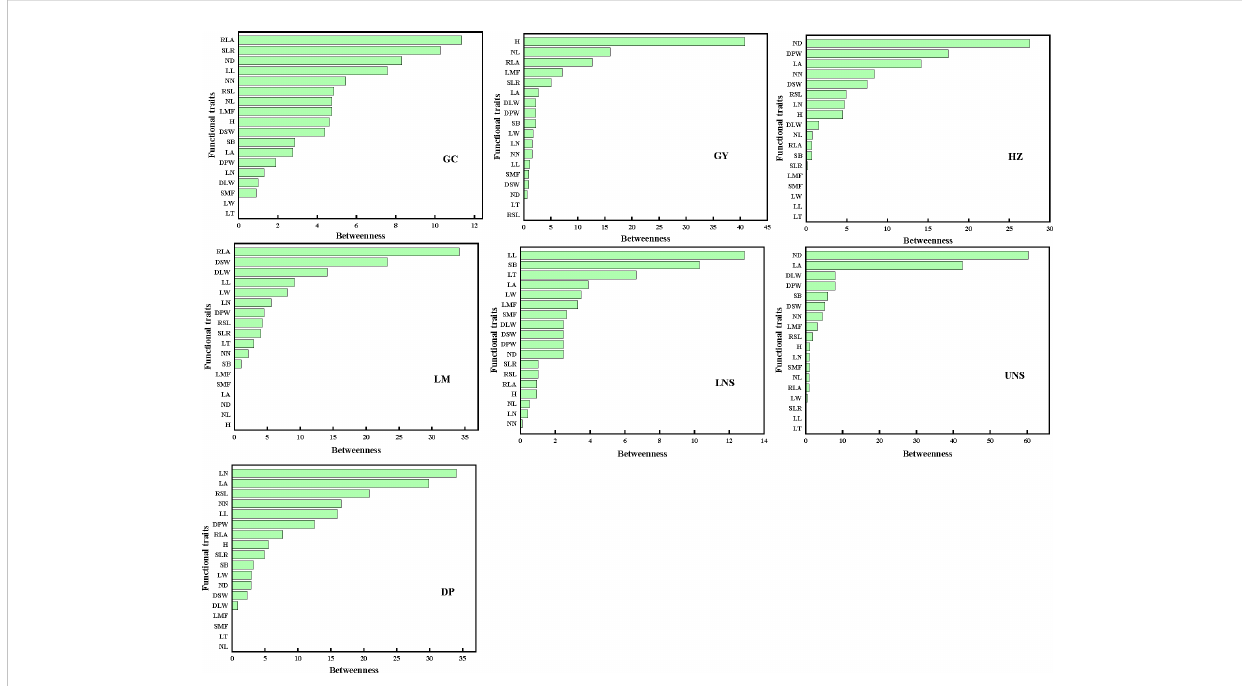
FIGURE 5 The betweenness of functional traits in plant trait network of impounded lakes and Grand Canal. GC, GY, HZ, LM, LNS, UNS and DP are abbreviations for Grand Canal, Gaoyou Lake, Hongze Lake, Luoma Lake, lower Nansi Lake, upper Nansi Lake and Dongping Lake,